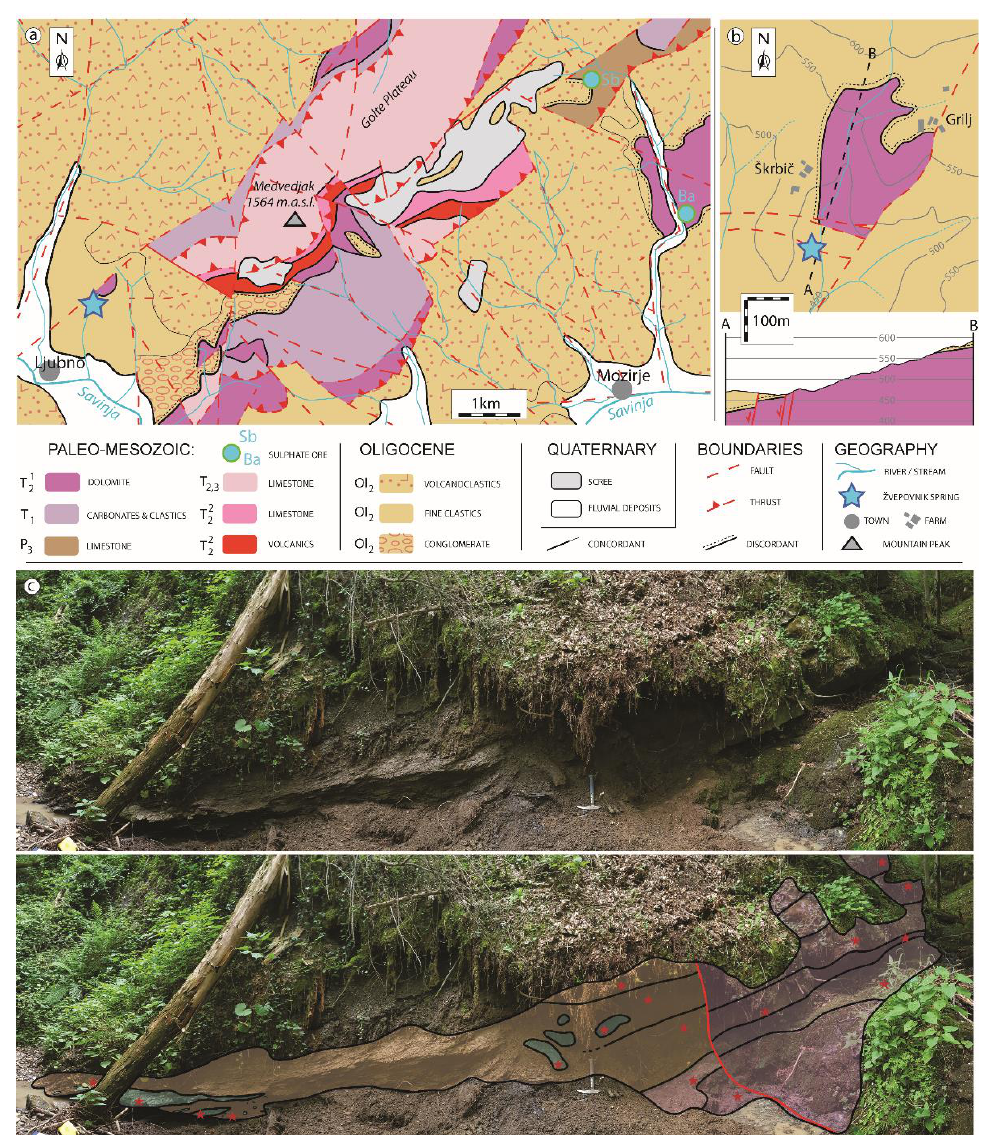
Figure 2. Geological characteristics of the Žvepovnik sulphur spring: ( a ) Geological map of the wider area with the location of the spring and Sb mineralisation (simplified from [47]), ( b ) detailed geological map and geological A–B cross-section of the Žvepovnik spring of the nearby surroundings (author: T.P.), ( c ) photograph and sketch of the sedimentologically analysed contact between Anisian dolomite/dolomite breccia (violet) and Oligocene clastics (light brown—shale/marl, blue—breccia) with positions of investigated samples (red stars); outcrop is located approximately 100 m upwards in the same valley as the Žvepovnik sulphur